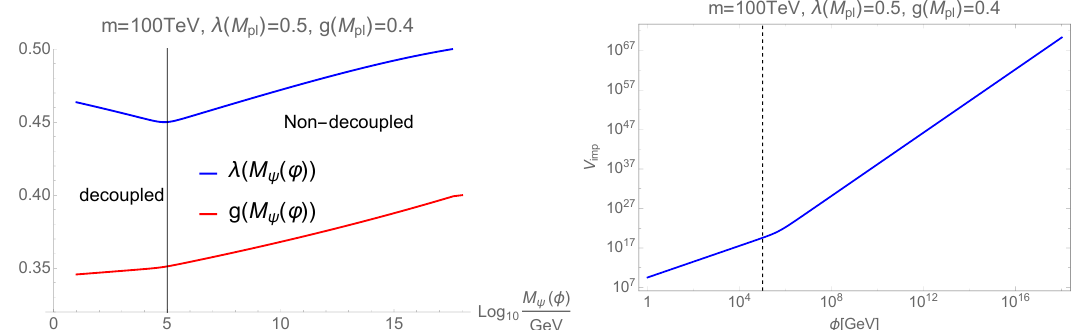
Figure 2 . Left: the running couplings at ~ (cid:22) = M ( (cid:30) ) are evaluated by using eqs. (2.23){(2.27). Here, we set (cid:21) ( M ) = 0 : 5, g ( M ) = 0 : 4 and m ( M ) = 100TeV as the initial values. Right: the pl pl pl corresponding improved one-loop e(cid:11)ective